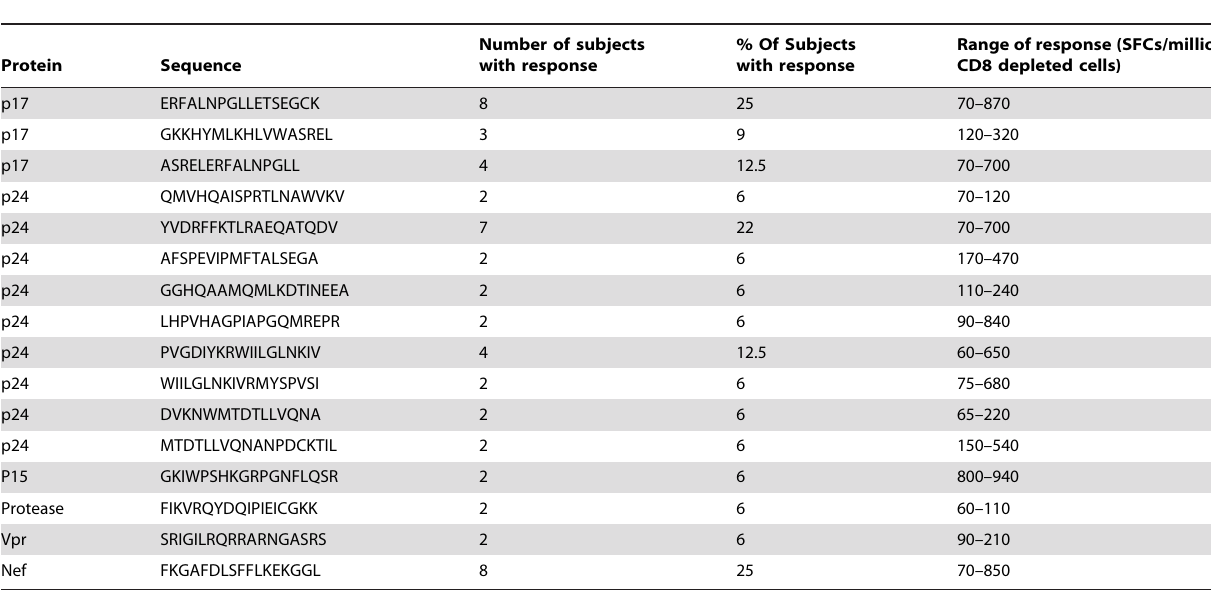
Table 1. Most frequently recognized clade C CD4 + T cell